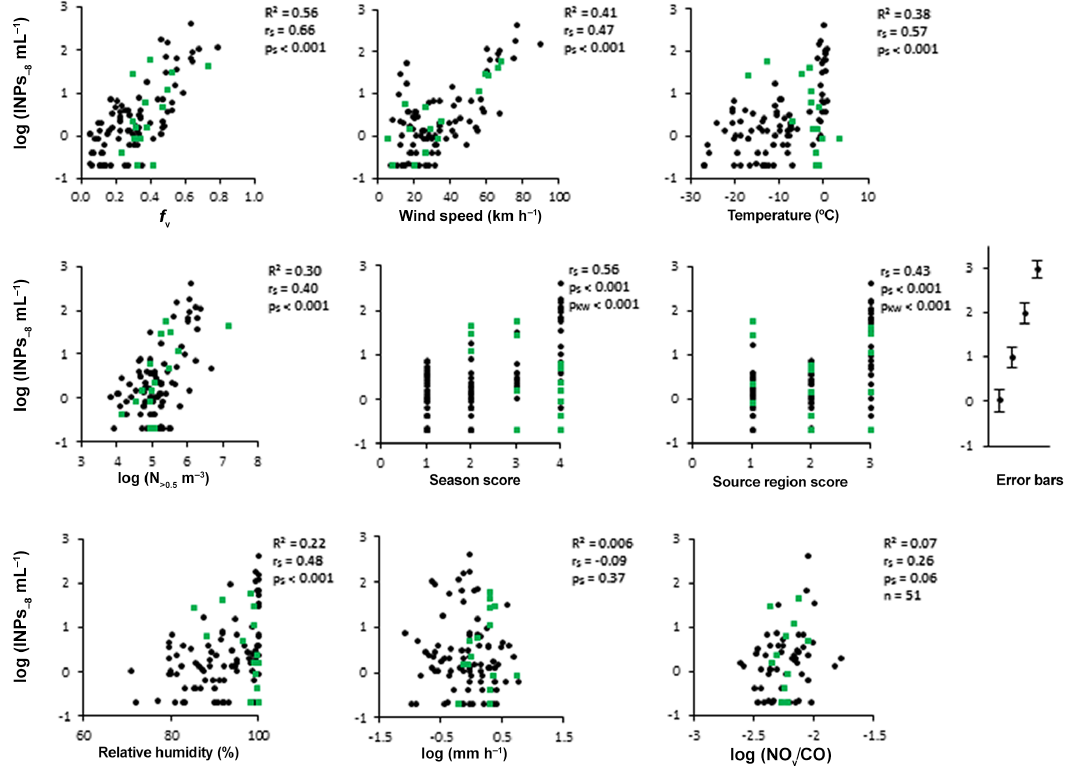
Figure 1. Relationships between INPs − 8 mL − 1 and singular environmental parameters for the first year of observations (black dots, n = 84, exception for the ratio NO y / CO with n = 51 due to missing data of trace gases). Shown are R 2 values, the coefficient of Spearman’s correlation r s and its probability p s calculated for the data belonging to the first year of observations. f V indicates the remaining fraction of water vapour in a precipitating air mass. In the panel “season score” 1 is for winter, 2 for spring, 3 for autumn, and 4 for summer. In the panel “source region score” 1 is for northern Europe, 2 for mixed conditions and 3 for southern Europe. For both “season score” and “source region”, values of Kruskall–Wallis’ test probability p kw are shown instead of R 2 . Data belonging to the second year of observations are represented as green squares ( n = 15, n = 12 for the ratio NO y / CO). Error bars associated to the measurement of 1, 10, 100, and 1000 INPs − 8 mL − 1 are represented close to the